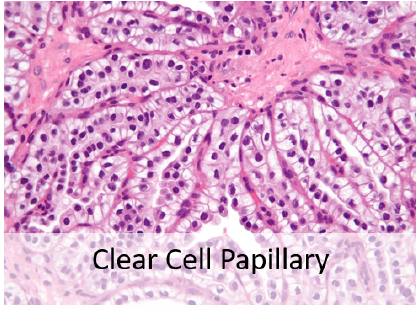
Figure 3. Clear cell papillary RCC